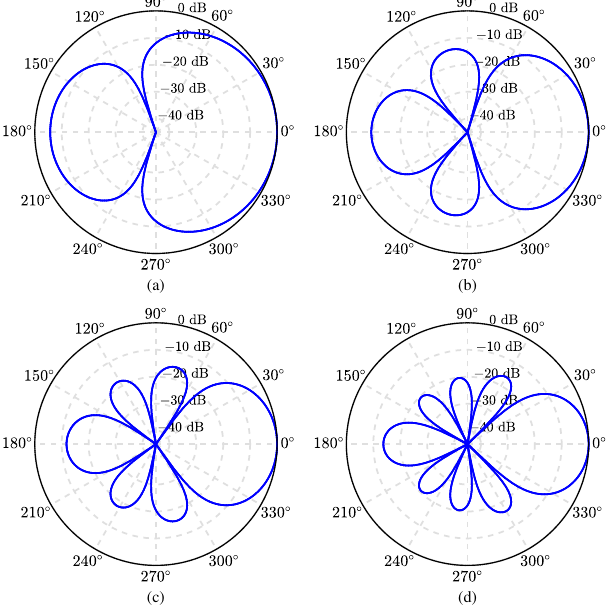
Figure 3. Beampatterns of the binaural heterophasic superdirective beamformer with various num- bers of microphones: ( a ) M = 6, ( b ) M = 8, ( c ) M = 10, and ( d ) M = 12. Conditions of simulation: f = 1 kHz, δ = 1 cm, and N = M